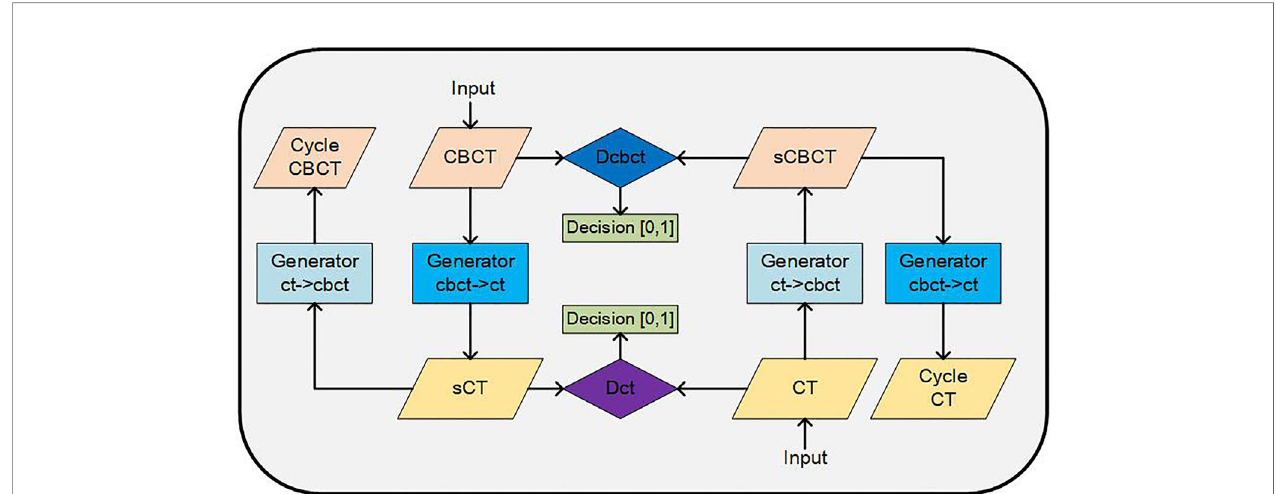
FIGURE 1 | Architecture of the CycleGAN network for image